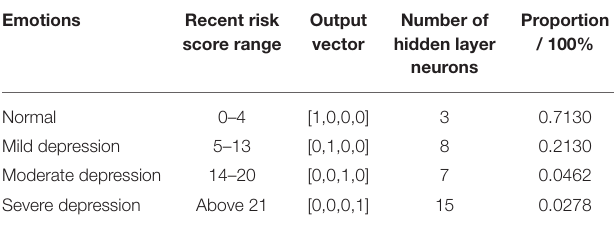
TABLE 2 | Negative emotion recognition results for